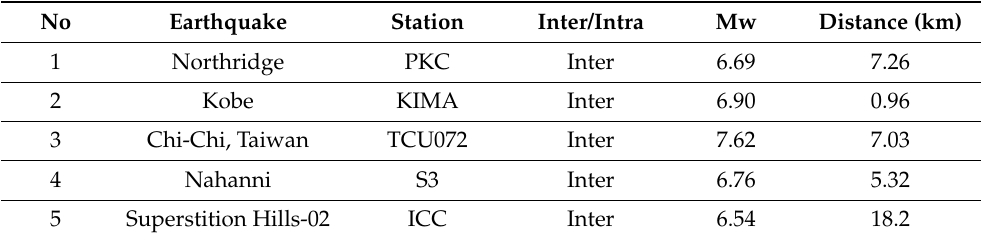
Figure 8. Response spectra of the generated input earthquakes and target response spectrum. Table 5. Characteristic of the seed